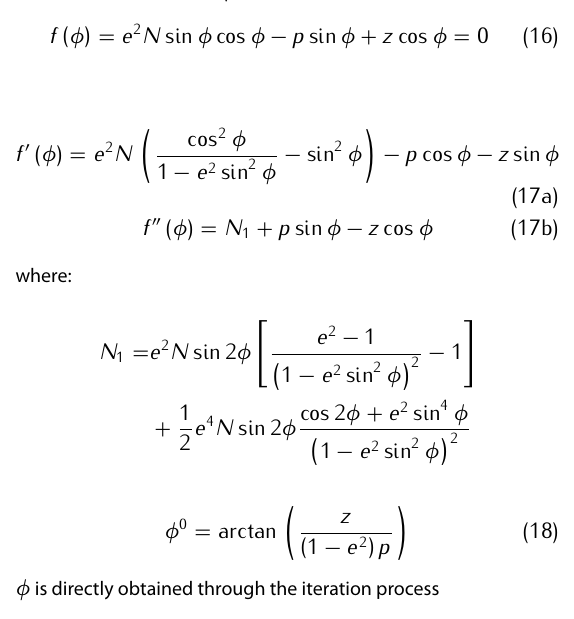
Algorithm A3 – “latitude” equation in terms of geocentric